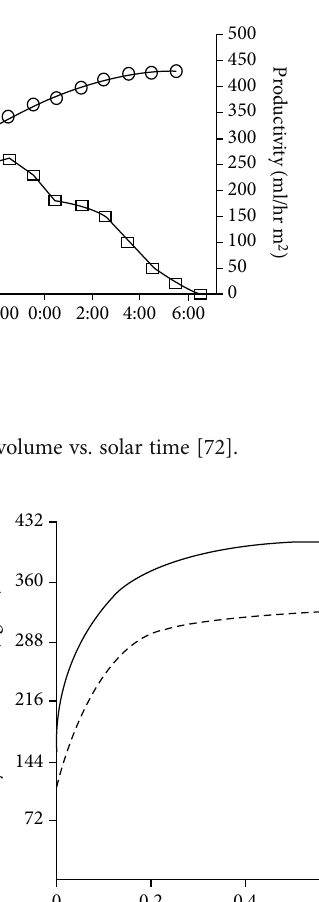
for the conventional solar still) u